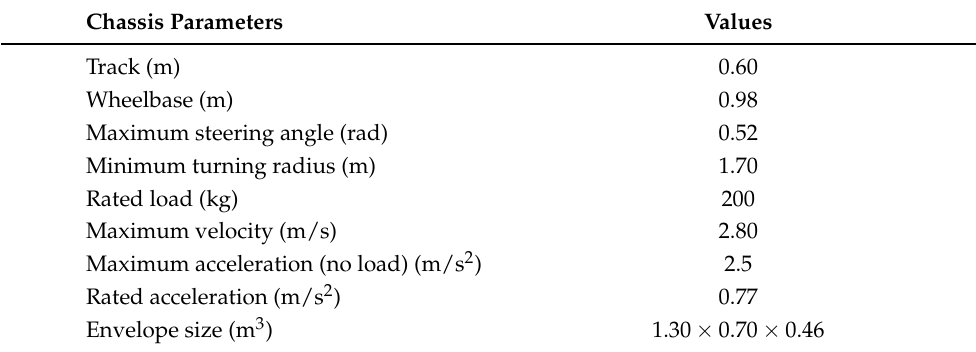
Table 6. Vehicle chassis